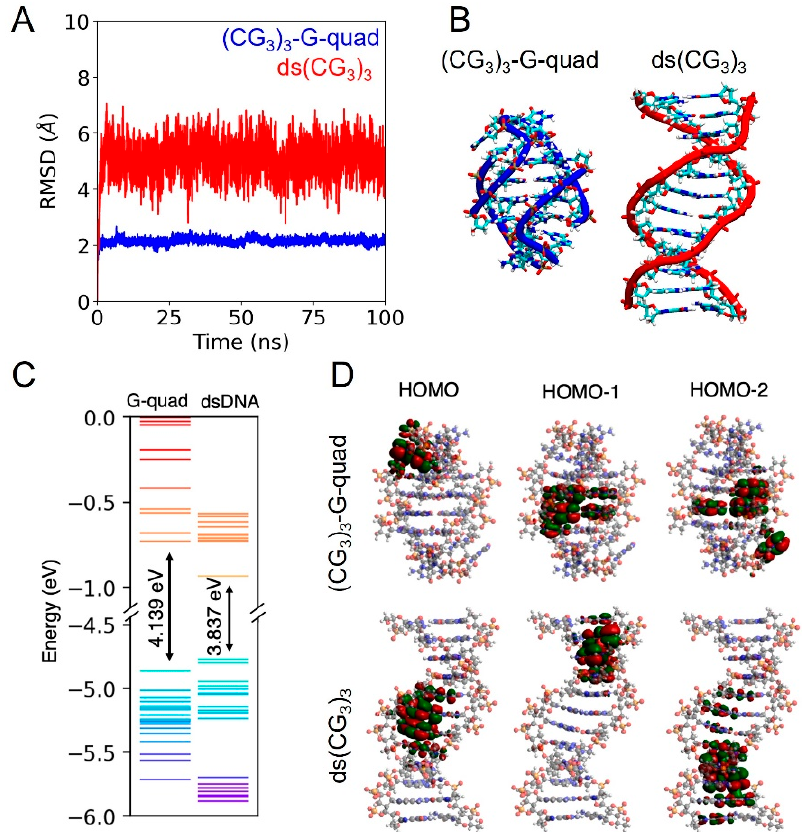
Figure 2. ( A ) Root mean square deviation (RMSD) for ds(CG 3 ) 3 (red line) and (CG 3 ) 3 -G-quad (blue line). ( B ) (CG 3 ) 3 -G-quad and ds(CG 3 ) 3 structures that are representative of the ones that were the most stable throughout the course of the MD simulation. ( C ) One-dimensional energy level plot for (CG 3 ) 3 -G-quad and ds(CG 3 ) 3 . ( D ) Three-dimensional iso-surface plot of the HOMO, HOMO-1, and HOMO-2 orbitals for (CG 3 ) 3 -G-quad and ds(CG 3 ) 3 structures.